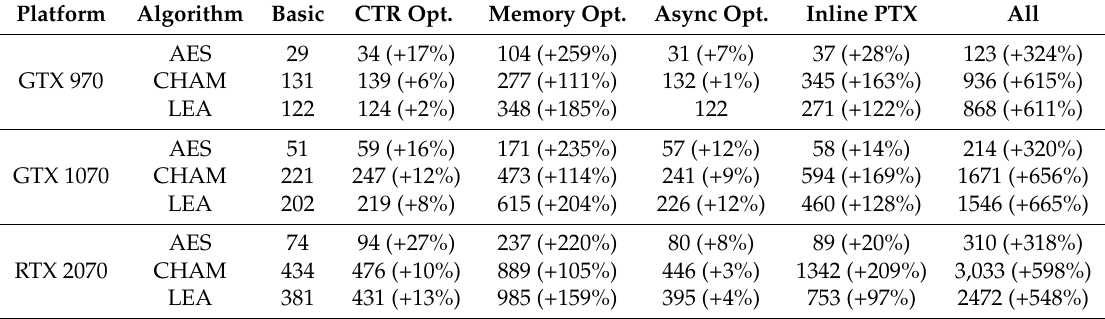
Table 6. Throughput by each optimization implementation (throughput is measured by Gbps).